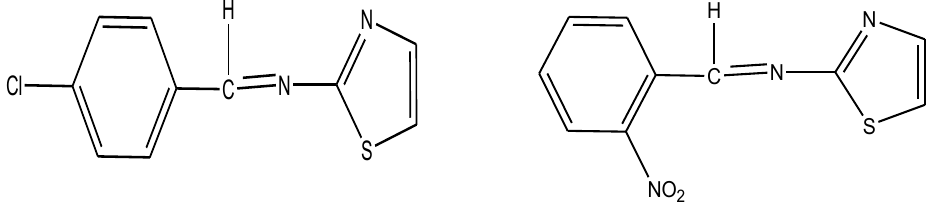
Figure 1 . Structure of Schiff base